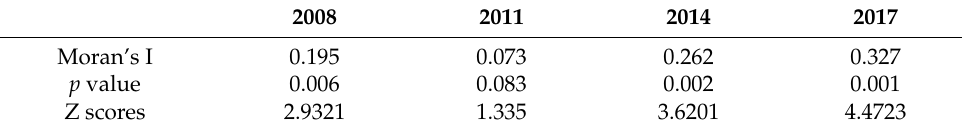
Table 4. Global Moran’s I and hypothesis tests of provincial urban land use efficiency in China.